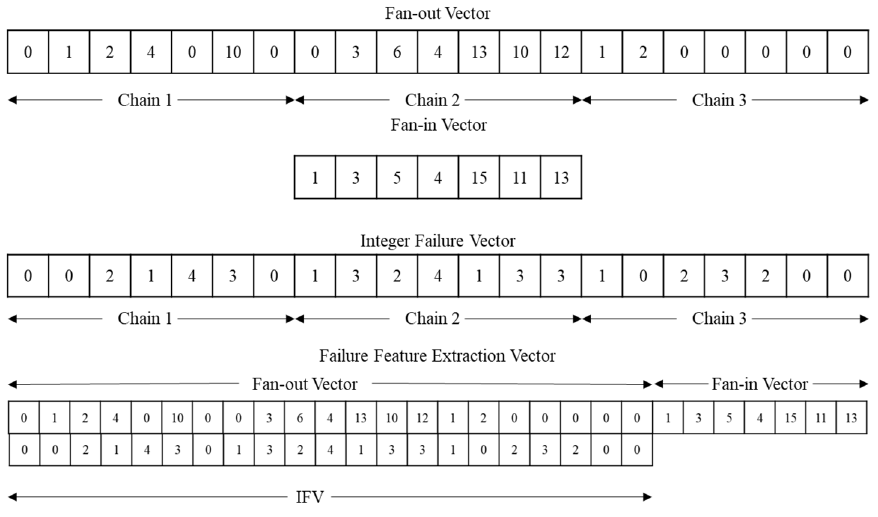
Figure 8. Example of failure feature vector.